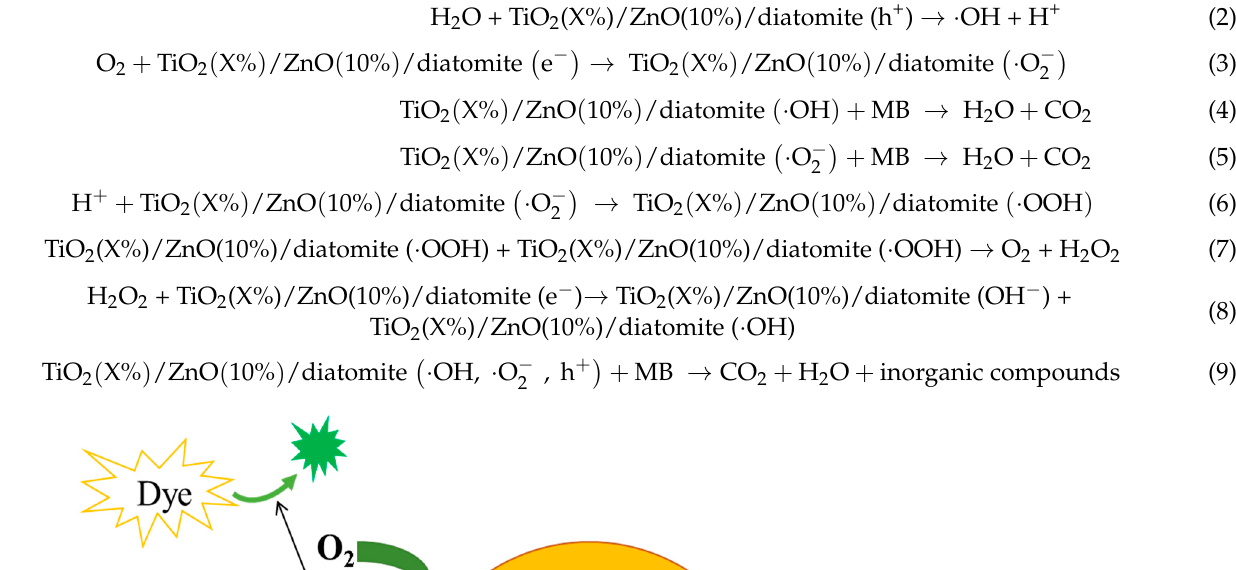
Figure 14. Degradation product of the photocatalytic degradation of gaseous acetone.